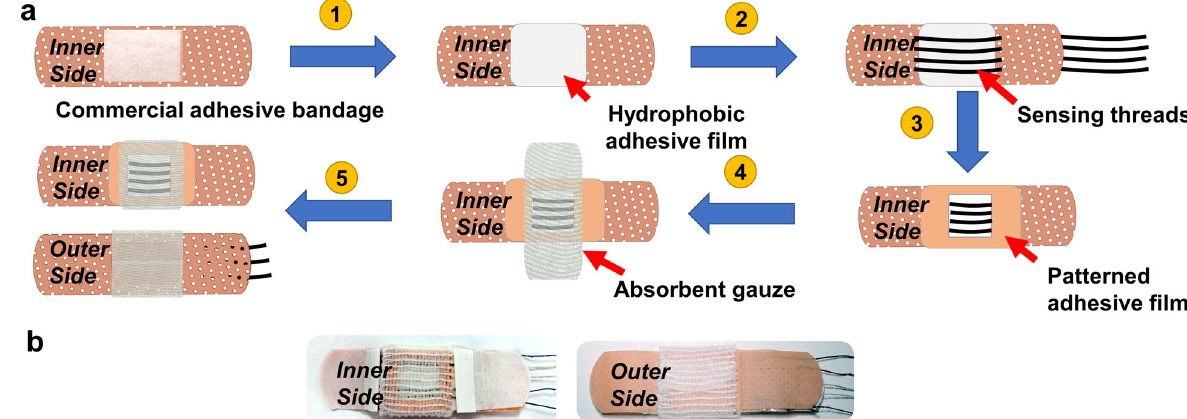
Fig. 1 Fabrication of thread-based sweat patch sensor. a Schematic of fabrication steps 1: adhesive hydrophobic fi lm is placed on the center of the commercial adhesive bandage 2: sew thread sensors on the bandage 3: patterned adhesive fi lm is placed to de fi ne the sensing zone 4: absorbent gauze is placed on the sensing zone 5: fold the gauze towards outer side of the bandage. b Photograph of the patch sensor